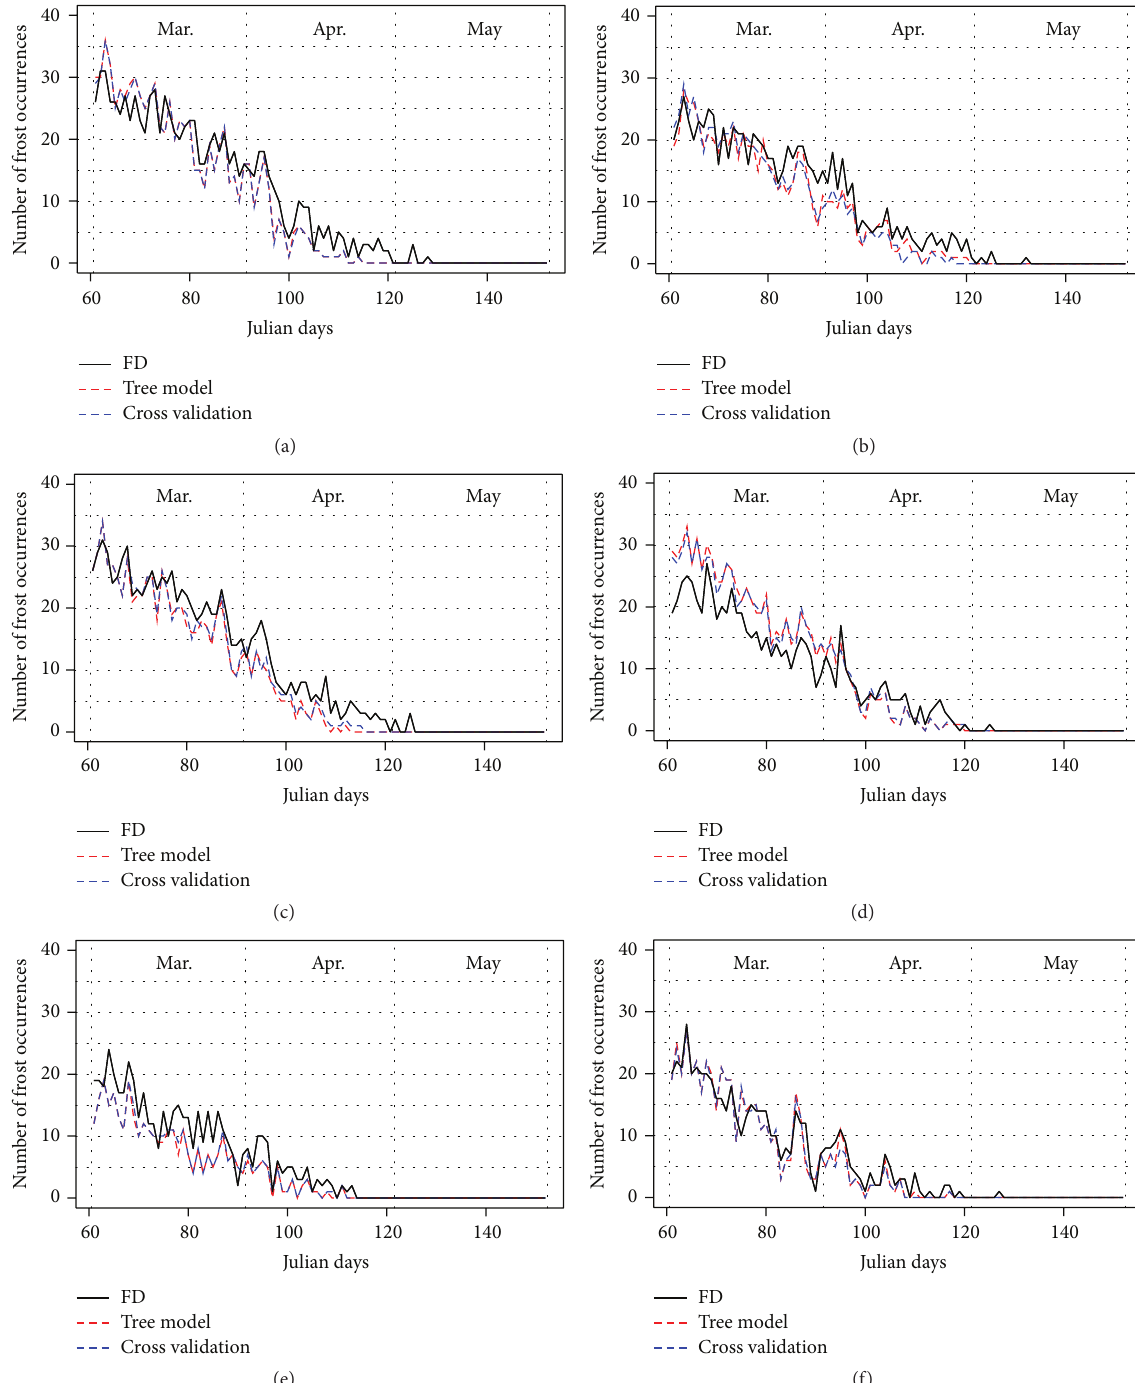
Figure 4: Observed and predicted frost in spring using the decision tree models: (a) Chuncheon (101), (b) Suwon (119), (c) Seosan (129), (d) Cheongju (131), (e) Gwangju (156), and (f) Jinju (192).